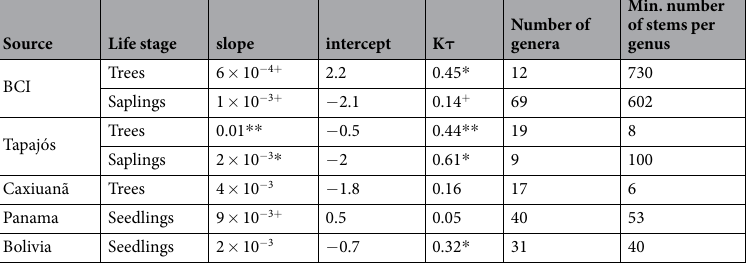
Life history stage also influenced drought-induced mortality of tree genera. Firstly, those models including the interaction between life history stage and WDA showed lower deviance information criteria (DIC) values than simpler models when using the data of BCI and Tapajós, the two sites where both trees and saplings were sampled (Table 4). Secondly, for the best model in Table 4, life stage and its interaction with WDA significantly explained drought-induced mortality (posterior mean = 0.003; 95% CI = 0.0006, 0.005). In addition, in Tapajós, the only